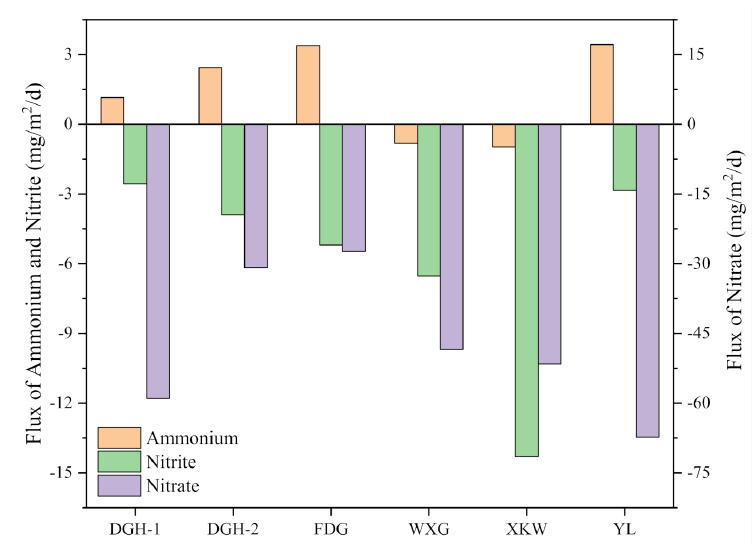
Figure 7. Apparent diffusion fluxes of DIN across the sediment–water interface of different sampling sites, from Jun 2019. Positive values represented upward flux and negative values represented downward flux.